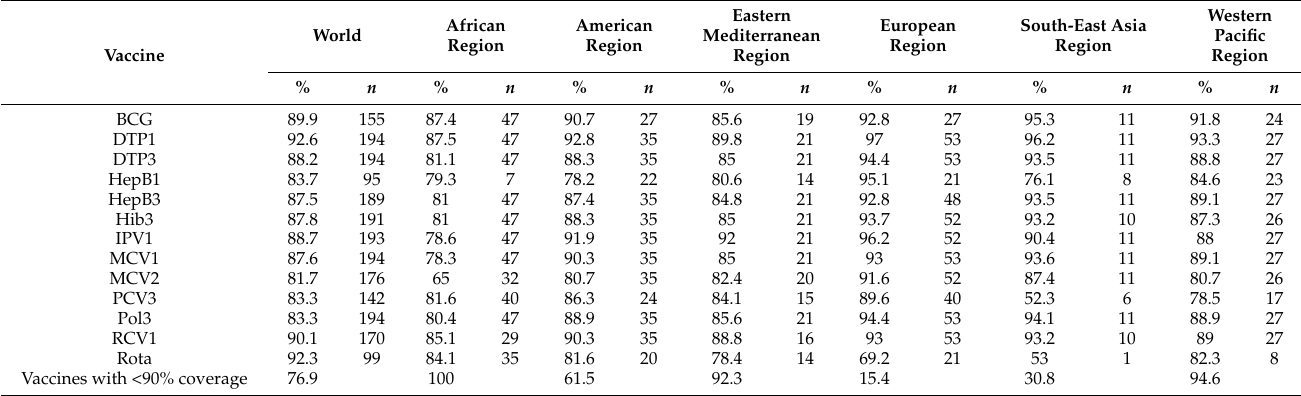
Table 1. Mean vaccination coverage for different routine vaccines in different regions of the World Health Organization in